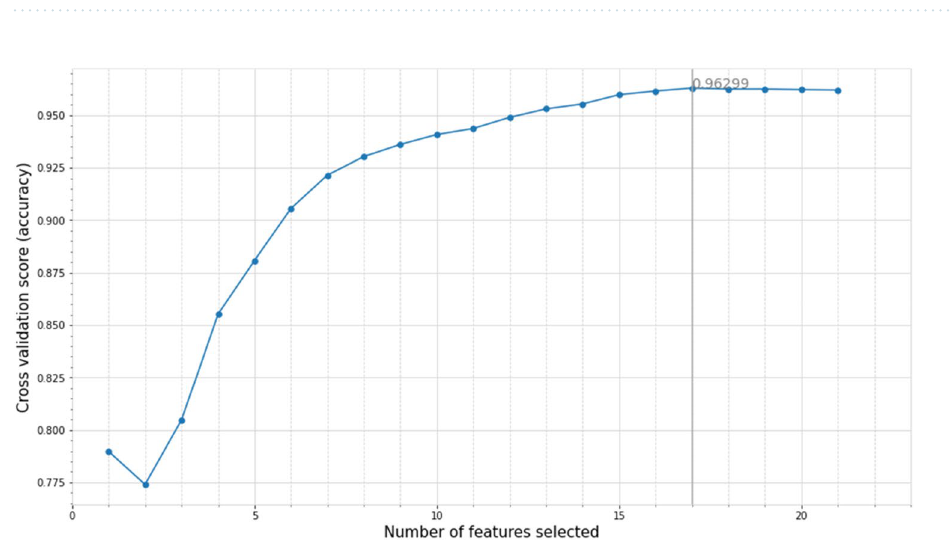
Figure 5. Feature selection results based on